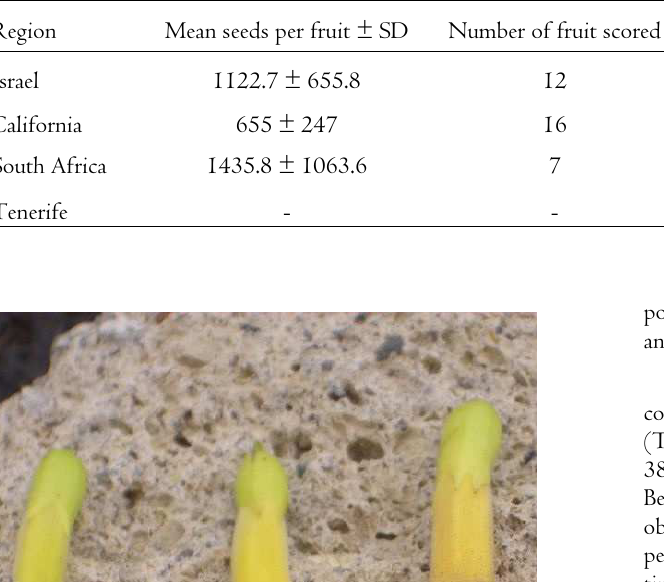
T ABLE 2. Seed production and viability in introduced population of Nicotiana glauca . Seed germination was assessed by sowing 20 or 25 (in